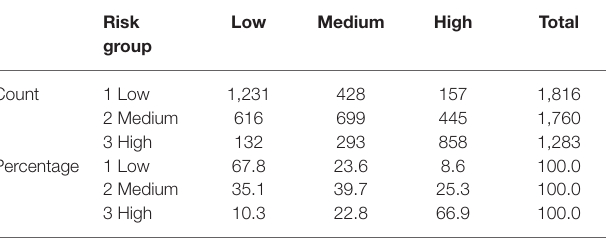
TABLE 3 | Classification table with cross-validated results of a stepwise discriminant analysis of the categorized risk for mood disorder